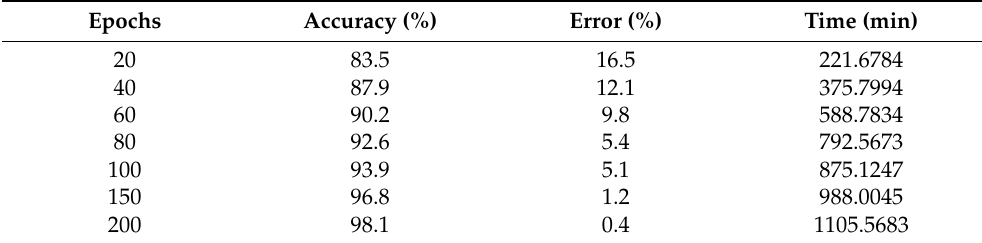
Table 8. Training accuracy on selected hyper parameters using real-time collected dataset.